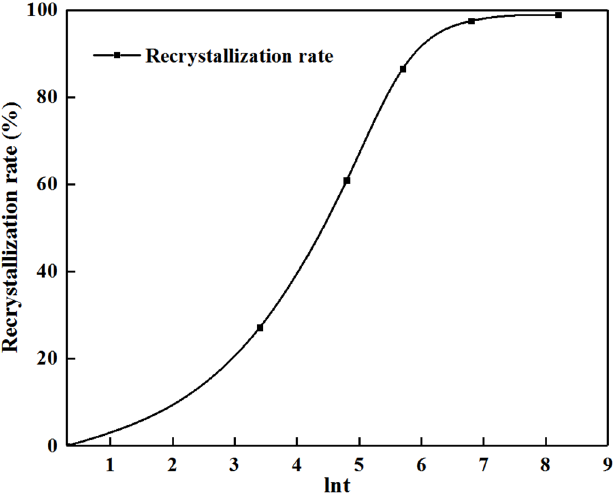
Figure 20. Relationship between recrystallization rate and annealing time .